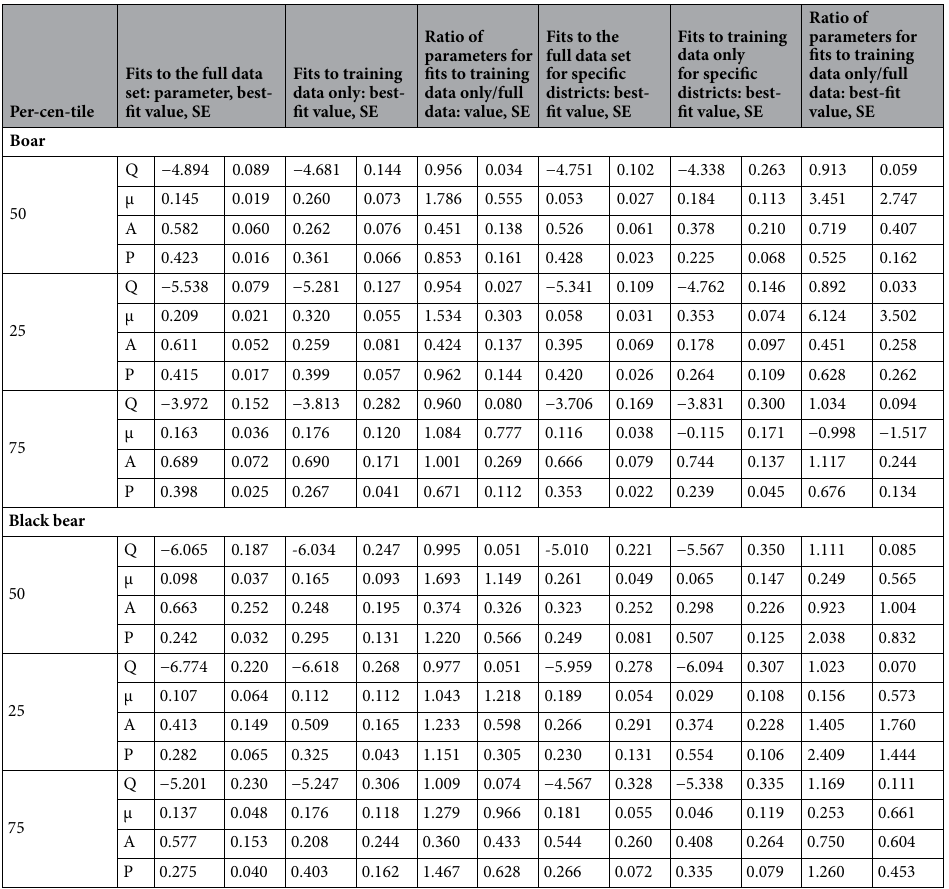
Table 3. Parameter values for fitting our model (Eq. 1A, 1B) by quantile regression to wild boar and Asian black bear